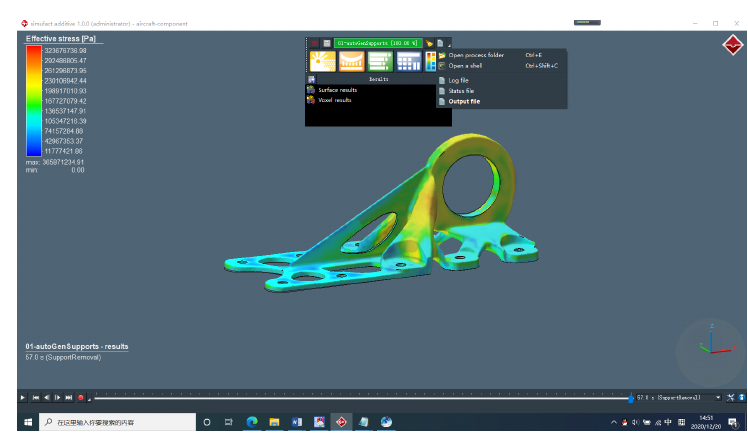
Fig. 3 Simulation output of Simufact